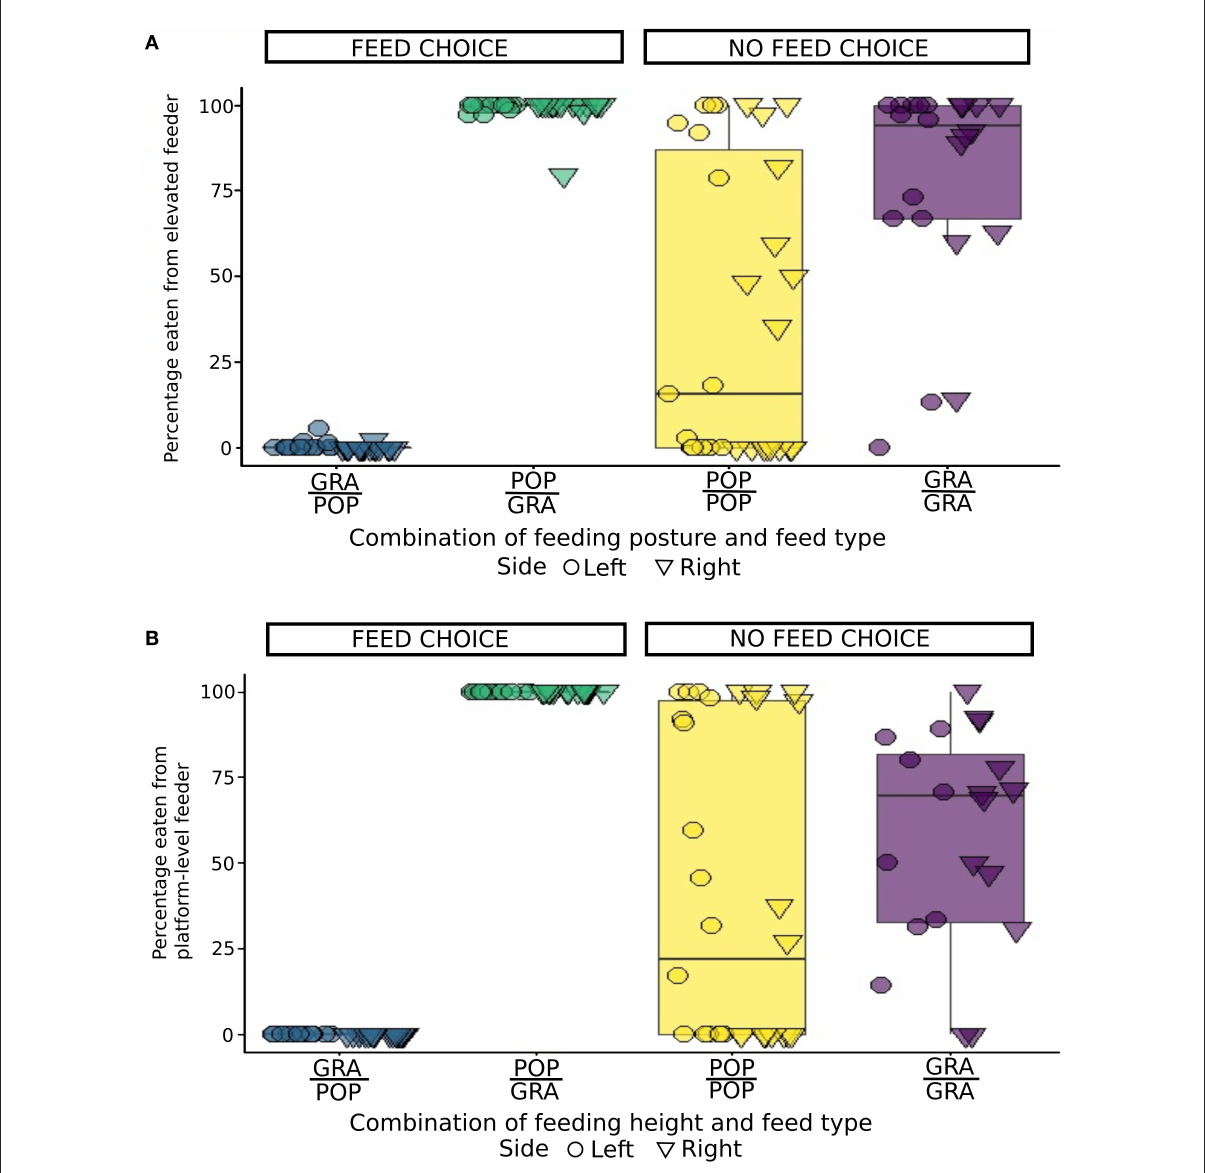
FIGURE5 Quantity of feed eaten from the highest of two feeders as a percentage of the total amount of feed eaten per goat ( n = 16, with two repetitions per individual) for Exp1 (A) and Exp2 (B) , depending on the combination of feed type and feeding posture (Elevated/Floor: POP/POP, GRA/GRA, POP/GRA and GRA/POP) or feeding height (Platform/Floor: POP/POP, GRA/GRA, POP/GRA and GRA/POP). Tests where no feed was eaten have been excluded (Exp1: n = 2 GRA/GRA; Exp2: n = 4 GRA/GRA). The dot and bars represent the mean and standard deviation of each combination presented on each side (right or